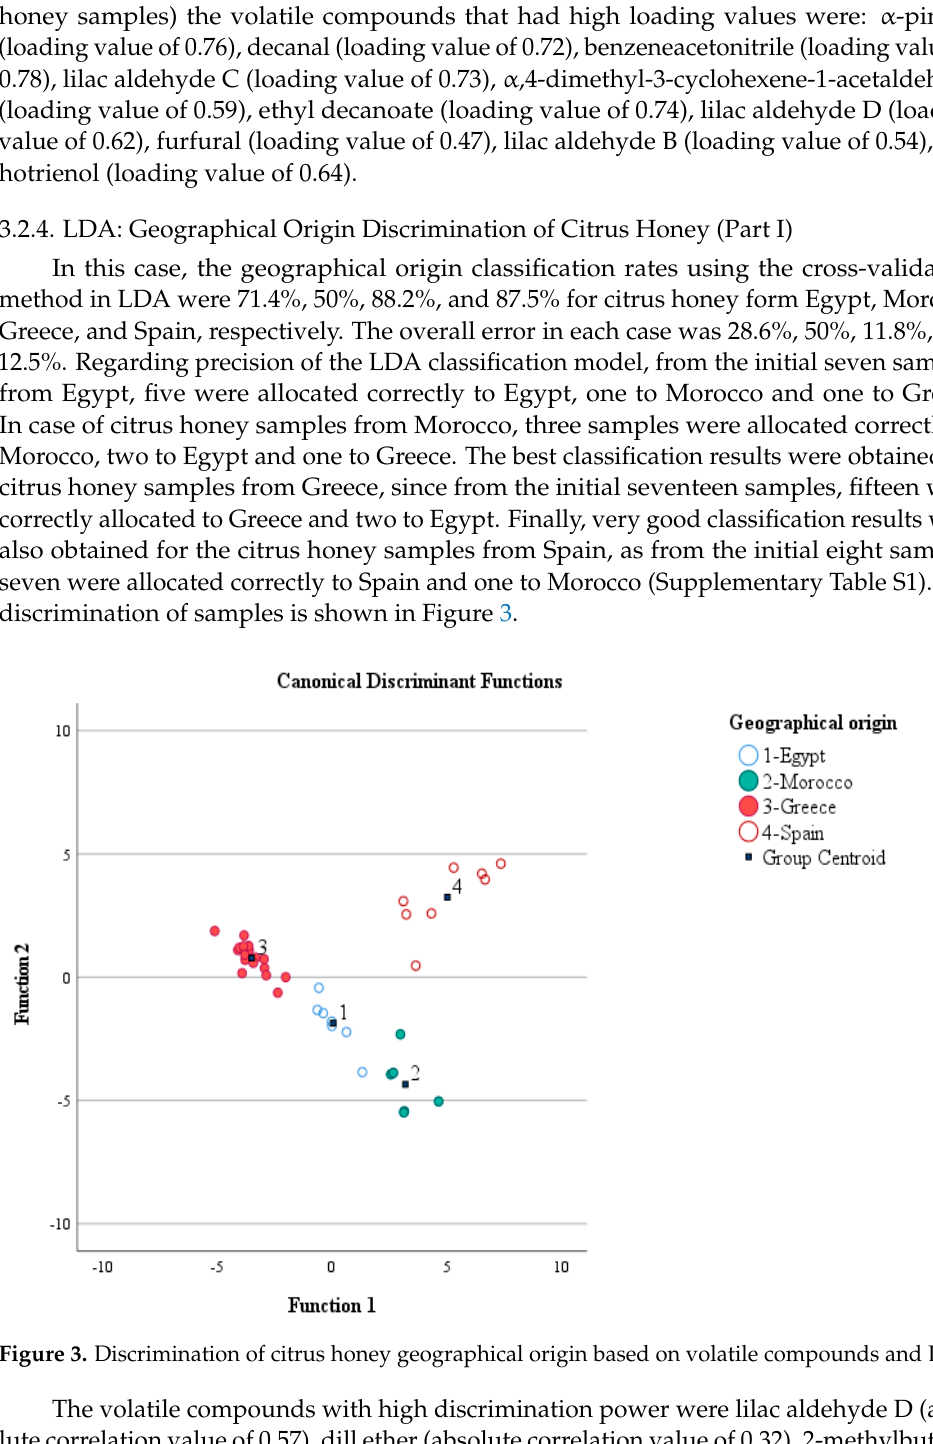
Figure 2. ( a ) Active volatile compounds (variables) of citrus honey related to geographical origin based on PCA. α : alpha; β : beta. ( b ) Score plot (distribution of citrus honey samples) in the multi- dimensional space of PCA with respect to geographical origin.